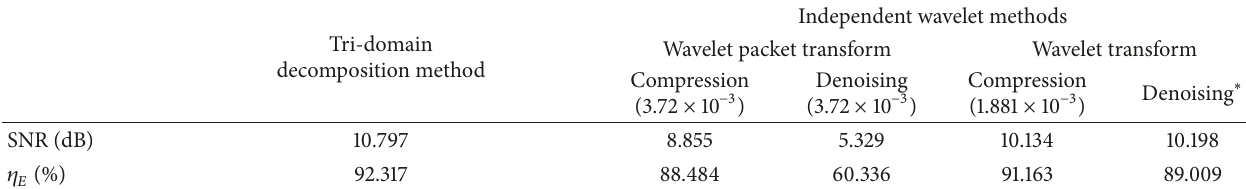
Table 2: Comparison of the SNR value and the energy-reservation ratio of the effective wave processed using diverse approaches.